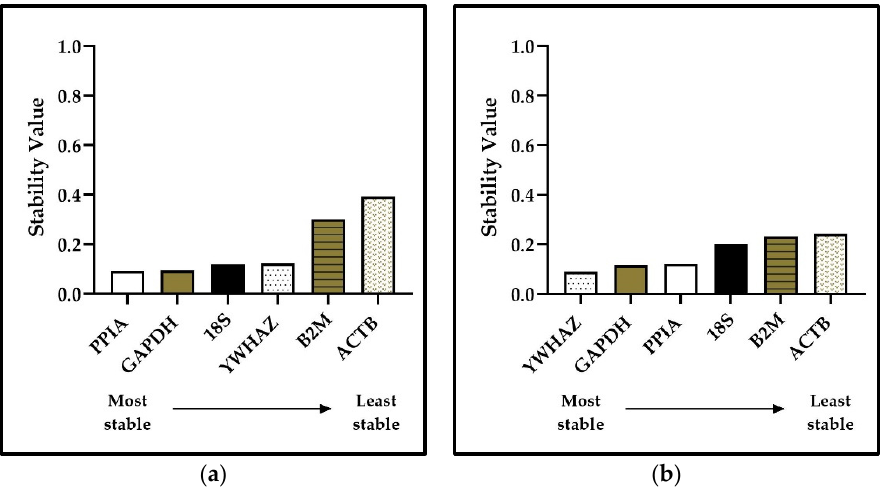
Figure 4. The NormFinder stability value results for the most stable gene across both unstimulated control cells and cells stimulated for 60 min per day. A separate NormFinder analysis was performed for cells seeded at ( a ) 5000 cells/cm 2 , and ( b ) 10,000 cells/cm 2 .